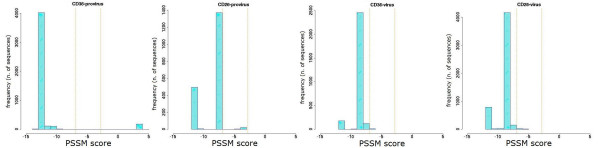
PSSM score distribution of V3 amino acid sequences from Pt.4. The PSSM score distribution of all variants from CD36- and CD26-provirus detected in Pt.4 at the moment of therapy interruption are shown together with those from CD36- and CD26-captured virus present one month after therapy stop. Vertical orange lines indicate percentiles for predicted co-receptor usage as in Fig. 6.